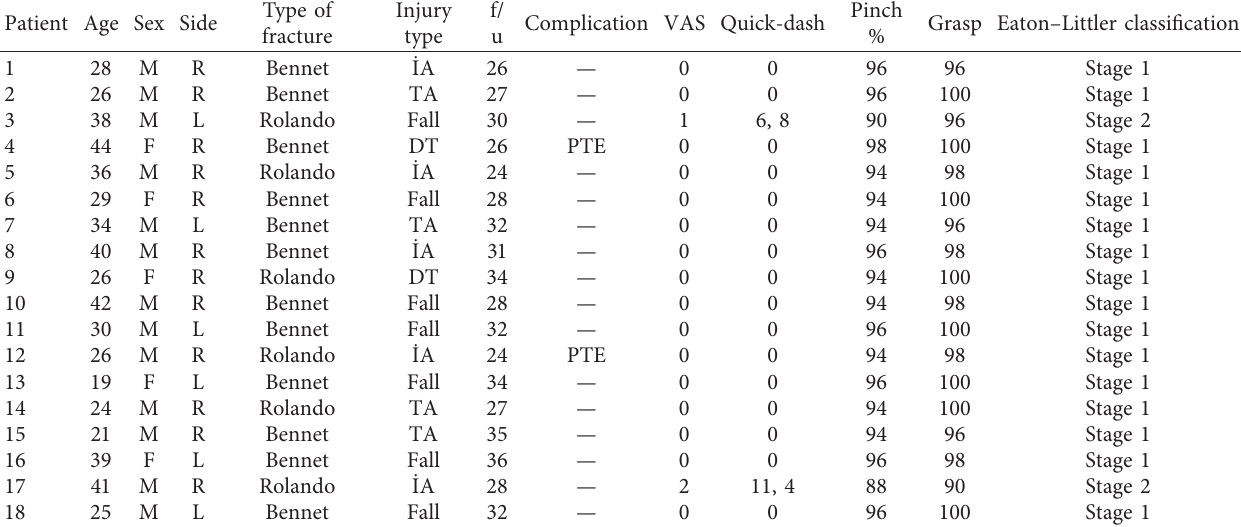
Figure 1: (a) Preop AP/lateral and oblique X-ray views of Bennet fracture. (b) Postop AP/lateral X-ray views of Bennet fracture. Table 1: Demographic data of the